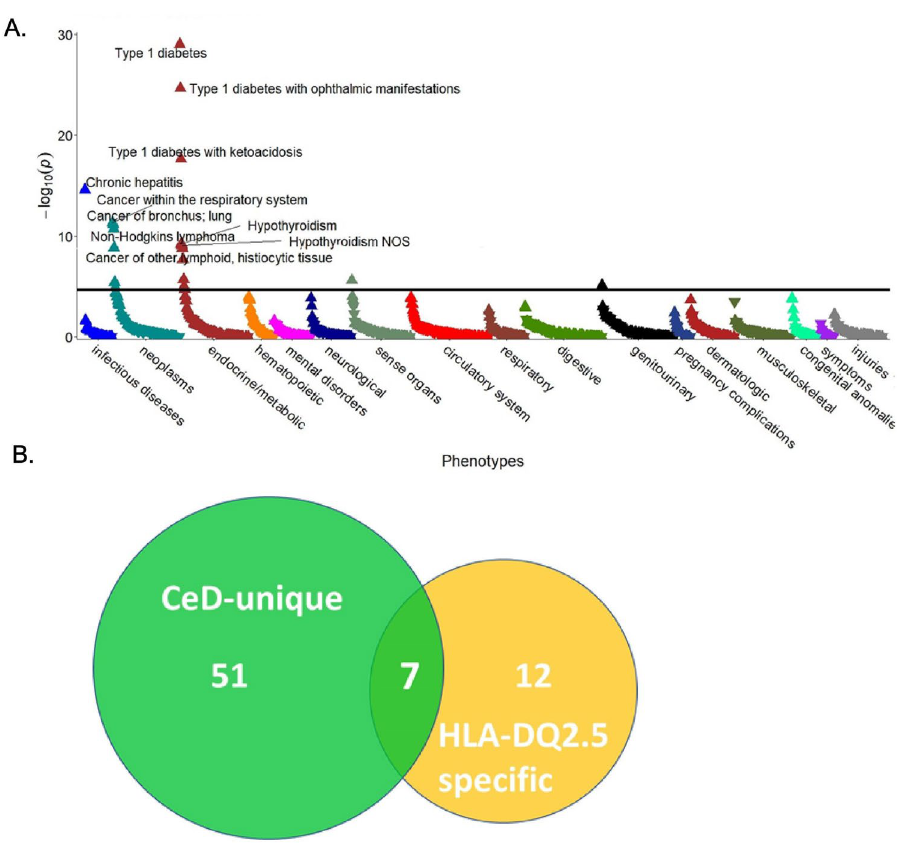
Figure 5. Conditions associated with two versus 0–1 HLA-DQ2.5 alleles in individuals without coeliac disease and their overlap with CeD-specific Phecodes. ( A ) The Manhattan plot highlights Phecodes that are significantly over/underrepresented as upwards/downwards pointing triangles. The ten most significant associations are shown. The black line indicates the significance level after Bonferroni adjustment for multiple testing. All analyses were adjusted for sex, age and body mass index, and p values are displayed in a − log10 format. ( B ) A Venn diagram illustrating the number of Phecodes specifically enriched in coeliac disease (CeD) subjects vs. controls (green) and overrepresented in noncoeliac patients with two vs. 0–1 HLA-DQ2.5 alleles (yellow). NOS not otherwise